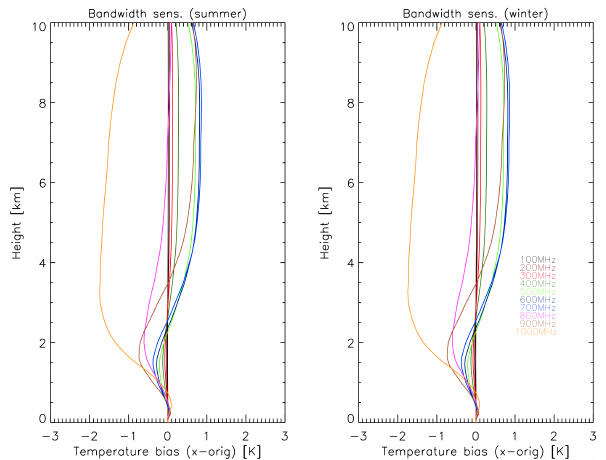
Fig. 9. The error in the retrieved temperature caused by the errors in TB by not taking into account channel bandwidth for different levels in the atmosphere. The errors are shown for both the mid-latitude summer (right) and the mid-latitude winter (left) soundings for different bandwidths (colour scale).